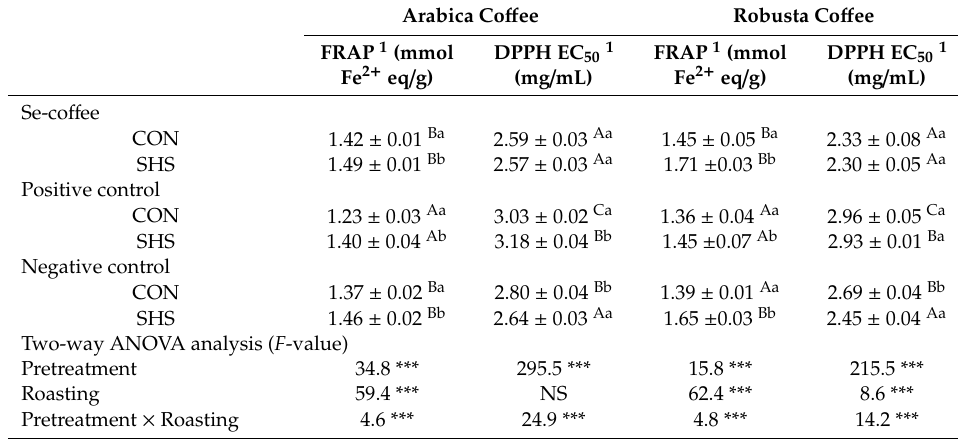
Table 2. FRAP reducing activity and DPPH scavenging activity (expressed as EC 50 ) of Se-co ff ee, positive control and negative control roasted via conventional (CON) and superheated steam (SHS) roasting.